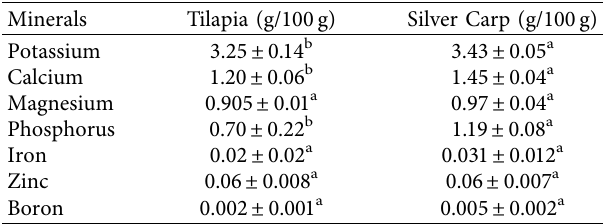
Table 5: Mineral contents found in Tilapia and Silver Carp fsh powder.